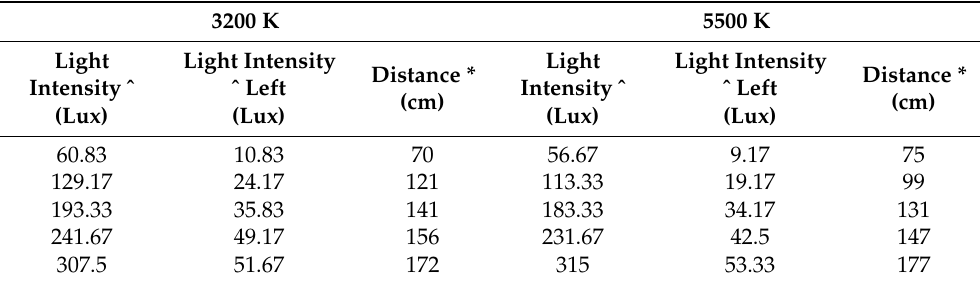
Table 5. Compare the relation among light intensity (Lux), light color (Kelvin), and detection distance (cm) for light source with diffuser from left